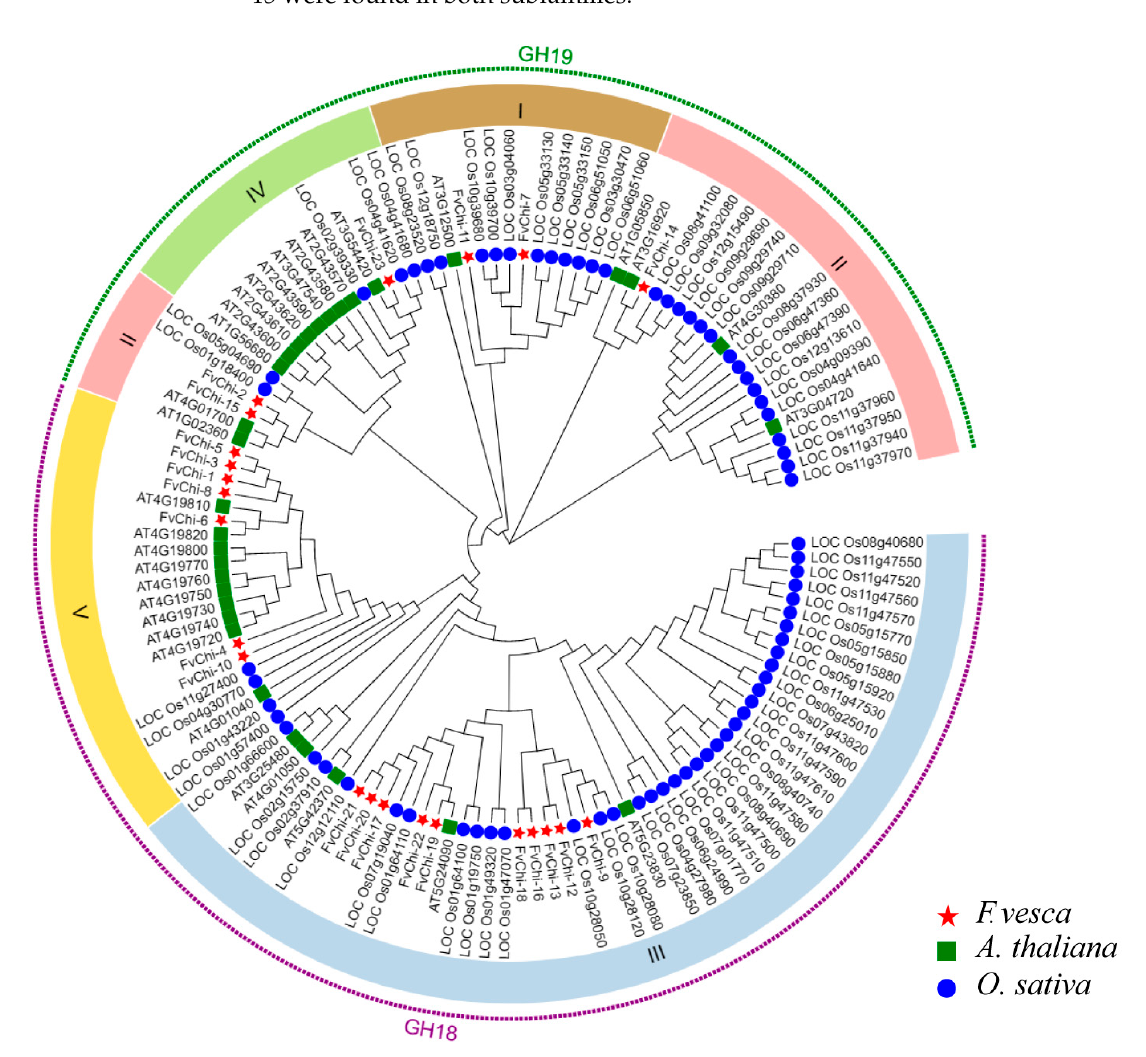
Figure 2. Phylogenetic analysis of chitinases proteins from A. thaliana , O. sativa , and F. vesca. Stars, squares, and circles represent F. vesca , A. thaliana , and O. sativa proteins, respectively.